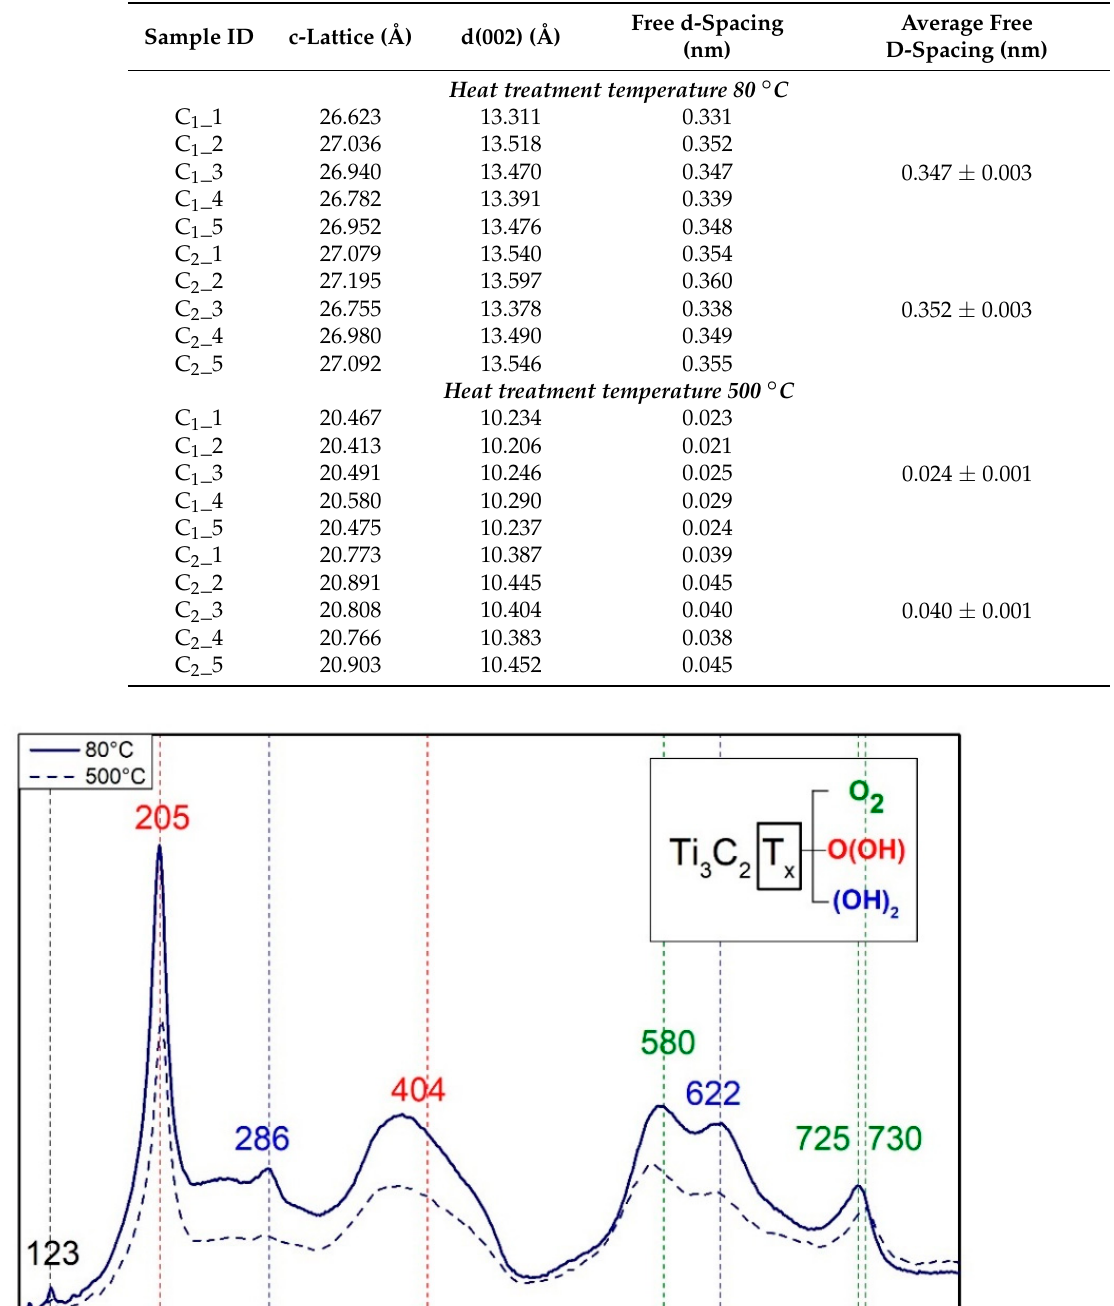
Table 1. C-lattice constants and respective d-spacing obtained through Bragg’s law for samples produced with the most concentrated suspension (C 1 ) and the least concentrated suspension (C 2 ).